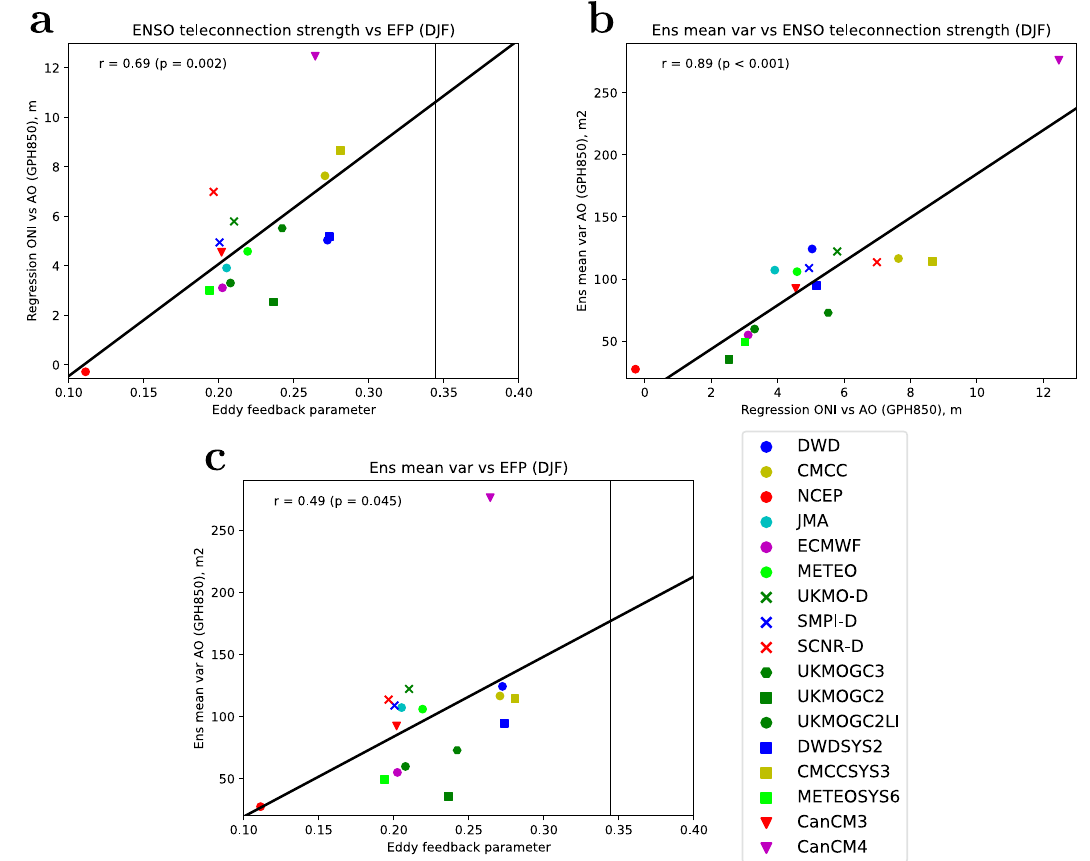
Fig. 3 EFP, teleconnection strength, and predictable signals. Correlation of ensemble mean a eddy feedback parameter (EFP) and ENSO teleconnection strength, b ENSO teleconnection strength and the predicted AO signal (measured by the ensemble mean variance), and c EFP and the predicted AO signal. The EFP and ENSO teleconnection strength are de fi ned in the Methods section. The value of the EFP computed from ERA5 reanalysis data is shown with a black vertical line in a and c (Fig. 2a), and for composites across systems with strong eddy feedback (Fig. 2b) and weak eddy feedback (Fig. 2c) — see ‘ Methods ’ section for details. As expected, the signal in the